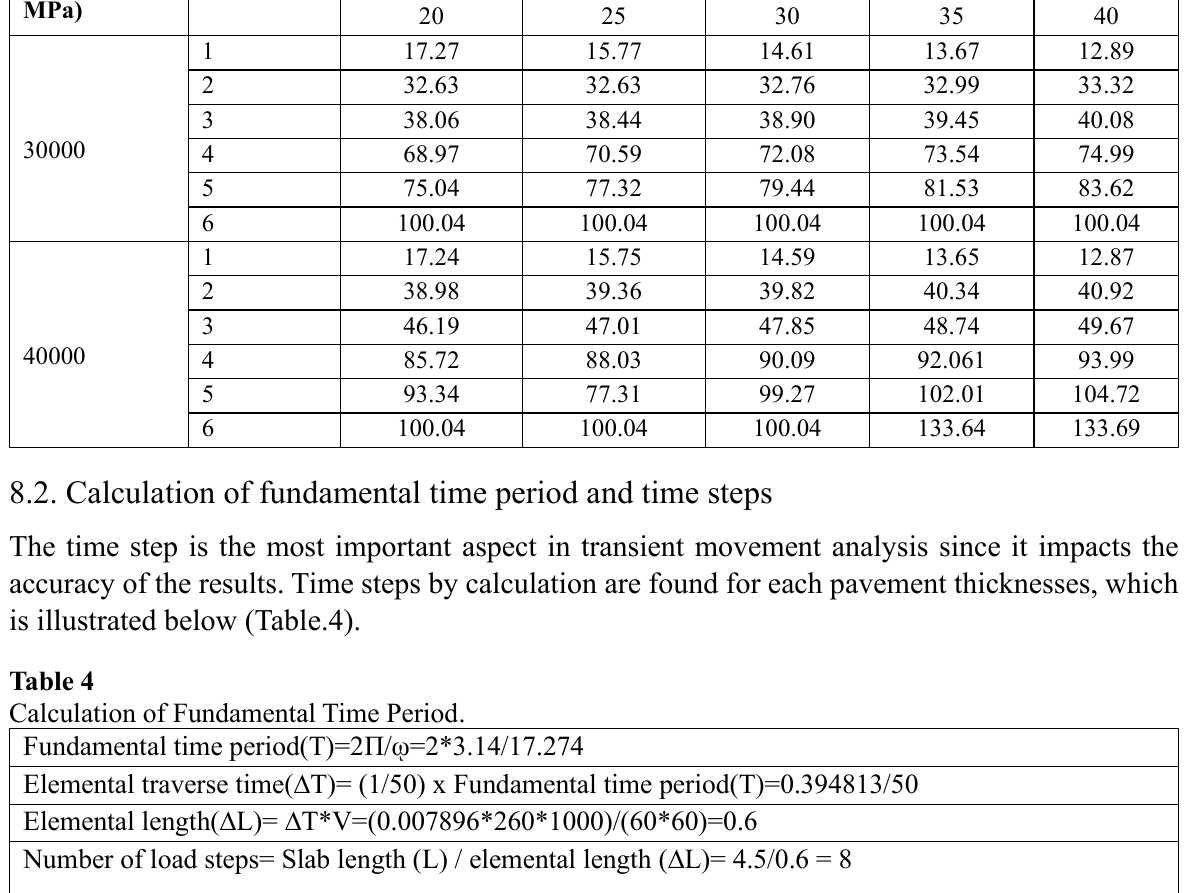
Modal Analysis Results Showing Fundamental Natural Frequency ῳ in Hertz. Elastic Modulus, E (